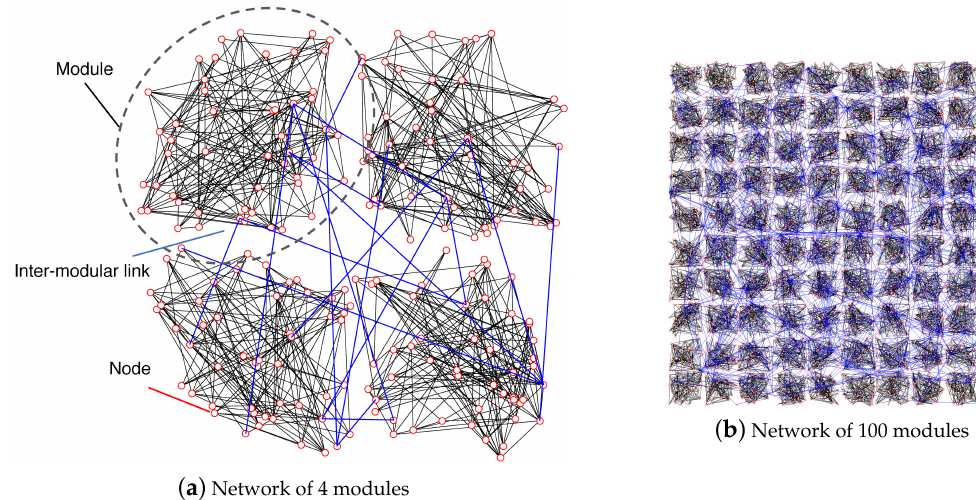
Figure 5. Examples of interconnected